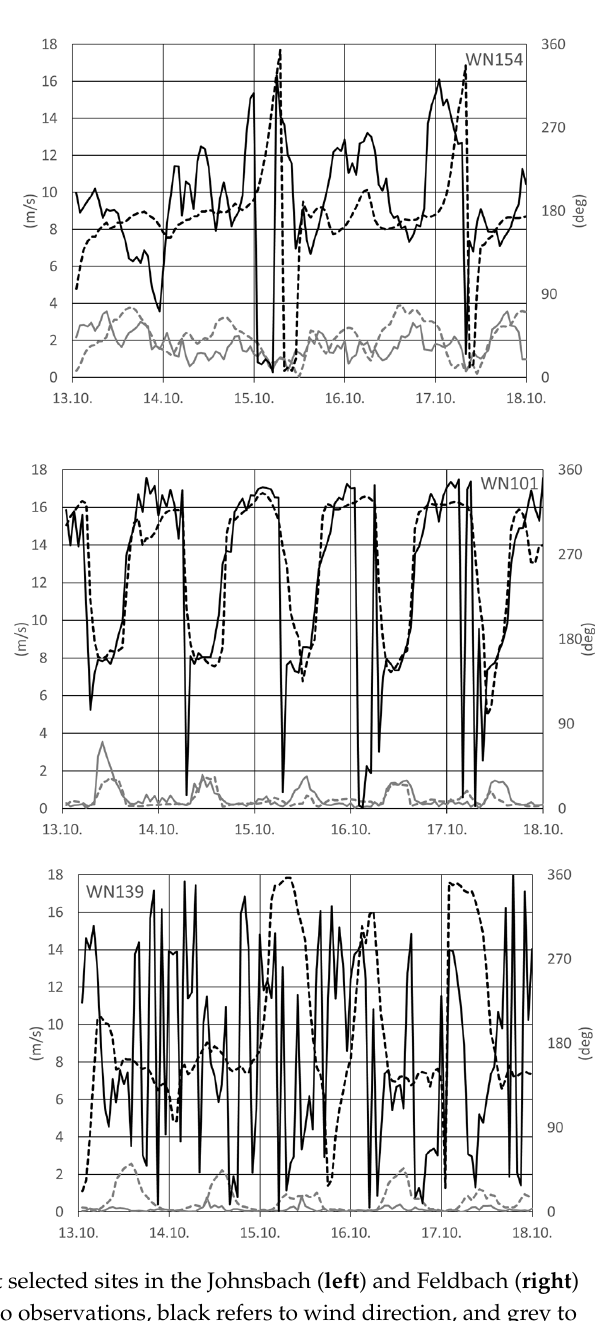
Figure 10. Simulated (grey) and observed (black) flow in the Johnsbach domain for 13 October 2017 at 7.p.m. (only every second modelled vector is shown). A nice example of a thermally-driven local wind in a small side valley is visible at the monitoring site WN101 (Figure 9, mid plot in the right panel). The side valley extends approximately 3 km in the north-south direction whereby the valley floor is less than 500 m wide. The observed diurnal variation in wind direction and speed is a textbook example for a local valley-wind system which is almost perfectly captured by the model. Figure 11 illustrates the complexity of the observed and modelled nocturnal drainage flows. Practi- cally each valley generates its own down-valley wind. However, as soon as wind speeds become very low, one observes low-frequent meandering motions. For instance, the reg- istered wind direction at the station WN135 indicates an up-valley wind in Figure 11, which is likely due to flow meandering as the observed wind speed was only 0.07 m s −1 at this time.